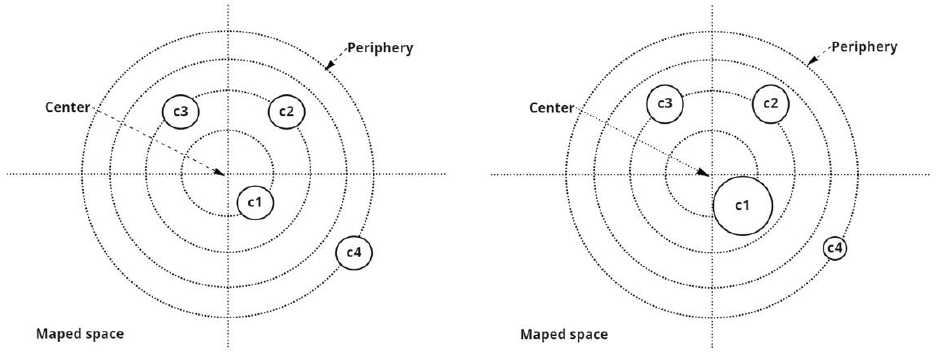
Figure 2. Representation of a “uniform” distribution ( left ) and a “dense” distribution ( right ). The size of the circles C representing the communities is proportional to the size of the community’s demand.